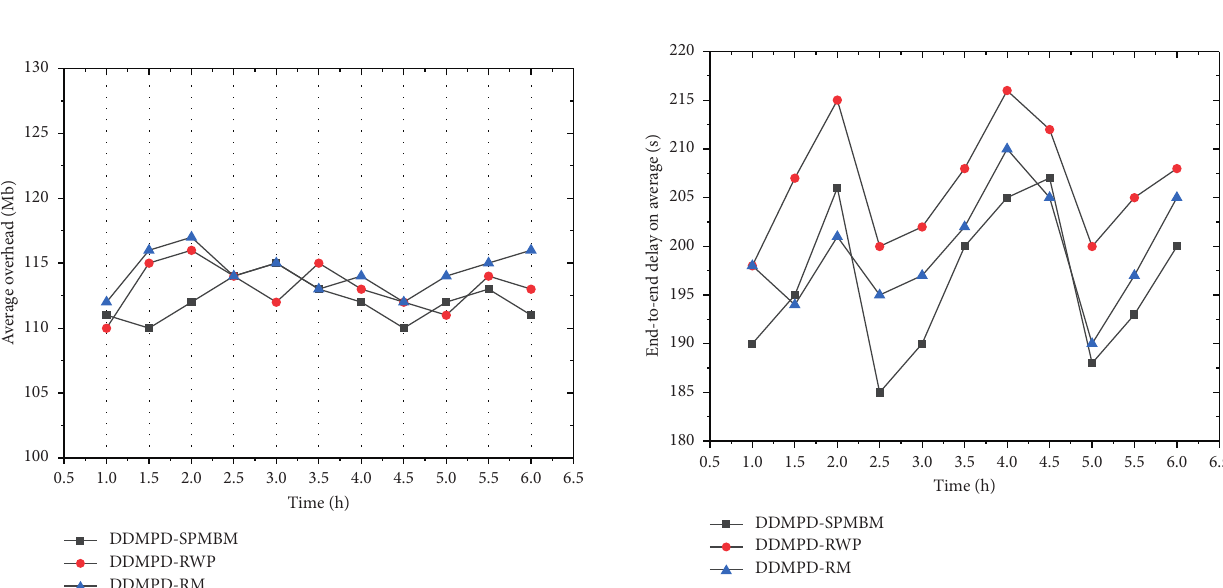
Figure 17: Relationship between energy consumption and time in three mobile models.